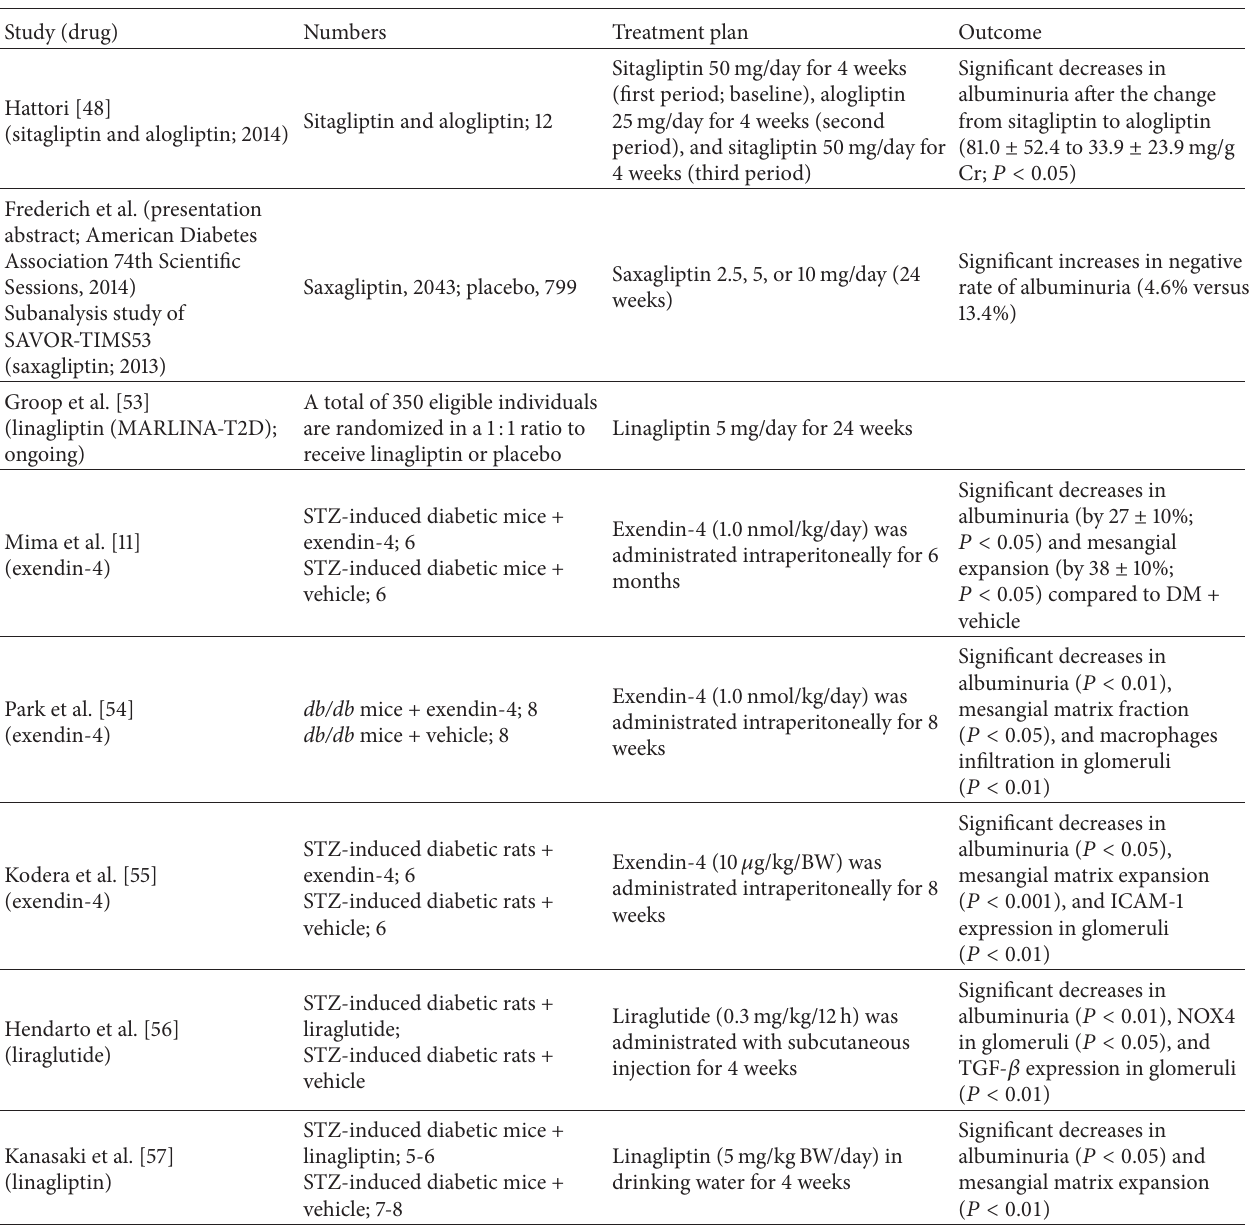
Table 1: Clinical trials and animal studies of selected incretin-based agents for kidney